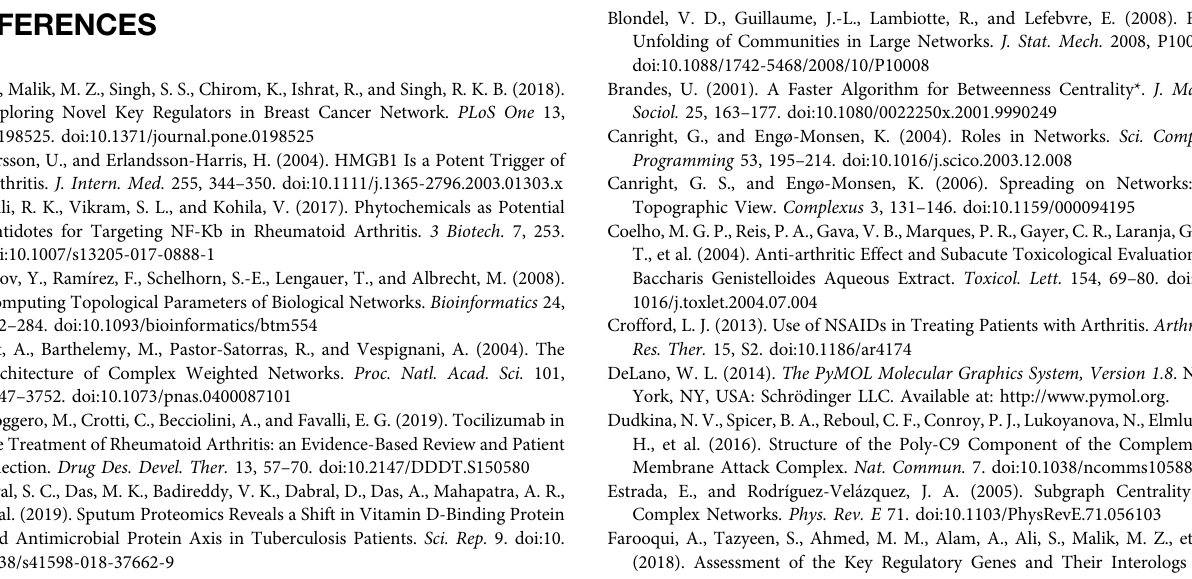
Supplementary Figure 2 | Scatter plots showing the correlation between the protein expressions of biological replicates in the experimental groups. Scattering plots of Pearson correlation comparing two biological replicates of iTRAQ reporter ion intensities, (A) AIA1 (114/113) vs. AIA2 (116/113); (B) DS1 (118/113) vs. DS2 (121/113); and (C) TXR1 (117/113) vs. TXR2 (119/113). The Pearson correlation coef fi cient (R2) is given for each plot. Supplementary Figure 3 | (A) Heat map of the proteins showing both signi fi cant difference and ≥ 1.5-fold change between the AIA and treatment groups (both DS and TXR200). (B) Western blot of the joint homogenate proteins of a different set of animals from each experimental group as a replicate result. Supplementary Figure 4 | (A) Venn diagram showing four common proteins between twolists ofproteins, viz.,list 1= 15proteins ( insilico keyregulators), list 2= 65 proteins ( ≥ 1.5-fold expressed proteins between AIA and Healthy). (B) Venn diagramshowingtwocommonproteinsbetweentwolistsofproteins,viz.,list1=19 proteins ( ≥ 1.5-fold expressed proteins between AIA and DS)and list 2 =17 proteins (signi fi cantly differentially expressed ( p ≤ 0.05) proteins between AIA and DS). (C) Venn diagram showing C9 as common among four lists of proteins, viz., list 1 = 15 proteins ( in silico key regulators), list 2 = 65 proteins ( ≥ 1.5-fold expressed proteins between AIA and healthy), list 3 = 11 proteins ( ≥ 1.5-fold expressed proteins between AIA and TXR groups), and list 4 = 27 proteins (signi fi cantly differentially expressed ( p ≤ 0.05) proteins between AIA and TXR). (D) Venn diagram showing manysetsofcommonproteinsamong fi velistsofproteins,viz.,list1=15proteins( in silico key regulators), list 2 = 11 proteins ( ≥ 1.5-fold expressed proteins between AIA and TXR groups), list 3 = 27 proteins (signi fi cantly differentially expressed ( p ≤ 0.05) proteins between AIA and TXR), list 4 = 19 proteins ( ≥ 1.5 fold expressed proteins between AIA and DS), and list 5 = 17 proteins (signi fi cantly differentially expressed ( p ≤ 0.05) proteins between AIA and DS). Supplementary Figure 5 | Molecular docking interaction studies (molecular interaction is depicted on the left while Ligplot showing molecules involved in interactions on the right side of each column) of TXR with the proteins identi fi ed as insilico keyregulators. (A) TXRwithcomplementcomponent9(C9); (B) TXRwith catalase (Cat); (C) TXR with aldehyde dehydrogenase 2 (Aldh2); (D) TXR with phosphofructokinase, platelet (Pfkp); (E) TXR with afamin (Afm); (F) TXR with leukotriene A4 hydrolase (LAH); (G) glycogenin 1 (Gyg1); (H) TXR with VPS29 retromer complex component (Vps29); (I) TXR withphospholysinephosphohistidine inorganic pyrophosphate phosphatase (Lhpp); (J) TXR with protein phosphatase 1 catalytic subunit gamma (Ppp1cc); (K) TXR with Serpin family A member 6(Serpina 6); (L) TXR with Ras-related C3 botulinum toxin substrate 1(Rac 1); (M) TXR with thyrotropin-releasing hormone receptor (Trhr); (N) TXR with protein disul fi de isomerase family A, member 3(Pdia3); and (O) TXR with dihydrofolate reductase